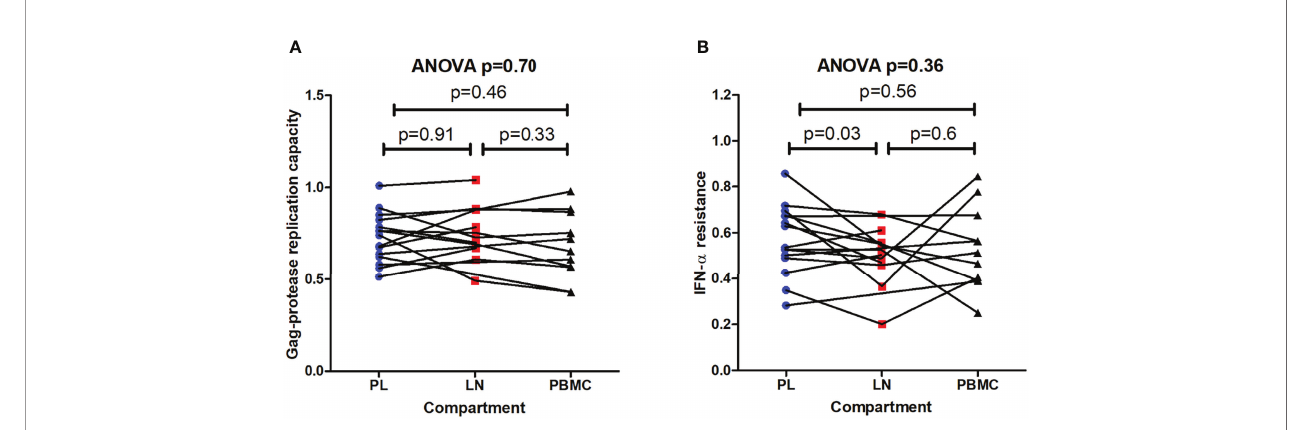
FIGURE 3 | Replication capacities and interferon-alpha resistance of viruses encoding gag-protease from pre-therapy plasma and the reservoir. (A) The replication capacities of the recombinant viruses encoding gag-protease from the lymph node (LN) and peripheral blood mononuclear cell (PBMC) reservoirs, as well as from the pre-therapy plasma (PL), in the absence of type I interferon alpha (IFN- a ) is shown. Replication capacity is expressed relative to the NL4-3 control (replication capacity = 1). (B) The IFN- a resistance (ratio of replication capacity in the presence and absence of IFN- a ) of these viruses is shown. The overall repeated measures ANOVA p value is shown as well as the paired T test p values from two-way